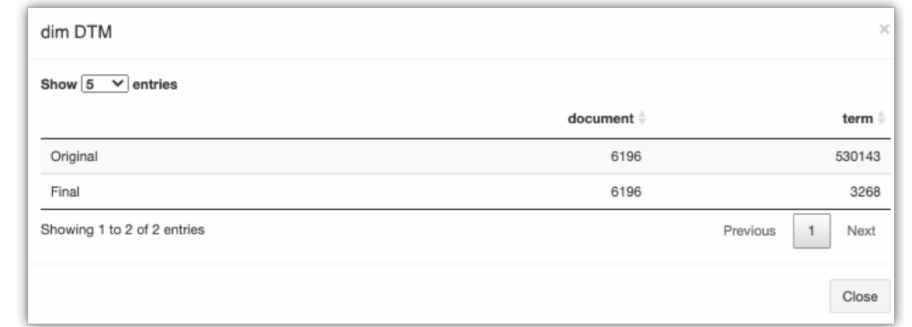
Figure 2. Document term matrix dimensions before (original) and after preprocessing